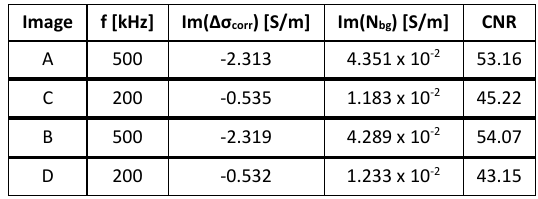
Table 6: Some quantitative data on the corrected images Im(Δ σ corr ) in figure (8).